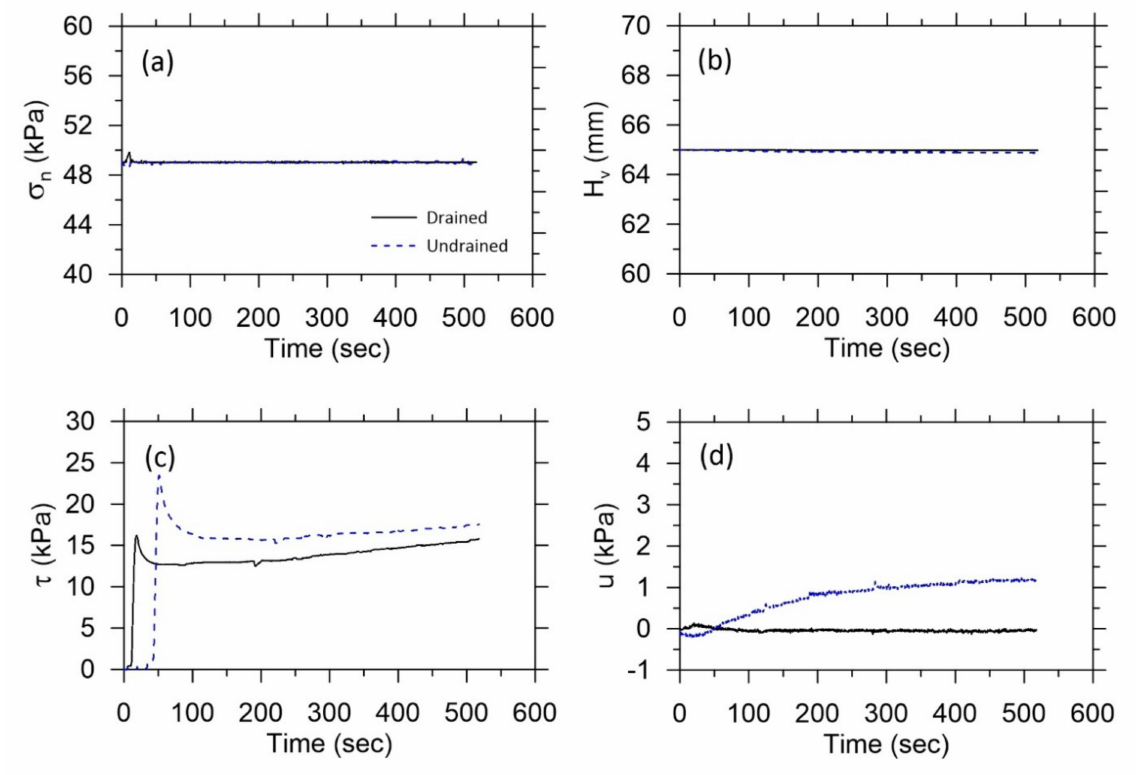
Figure 3. Drained and undrained shear stress measured in ring shear tests: displacement = 50